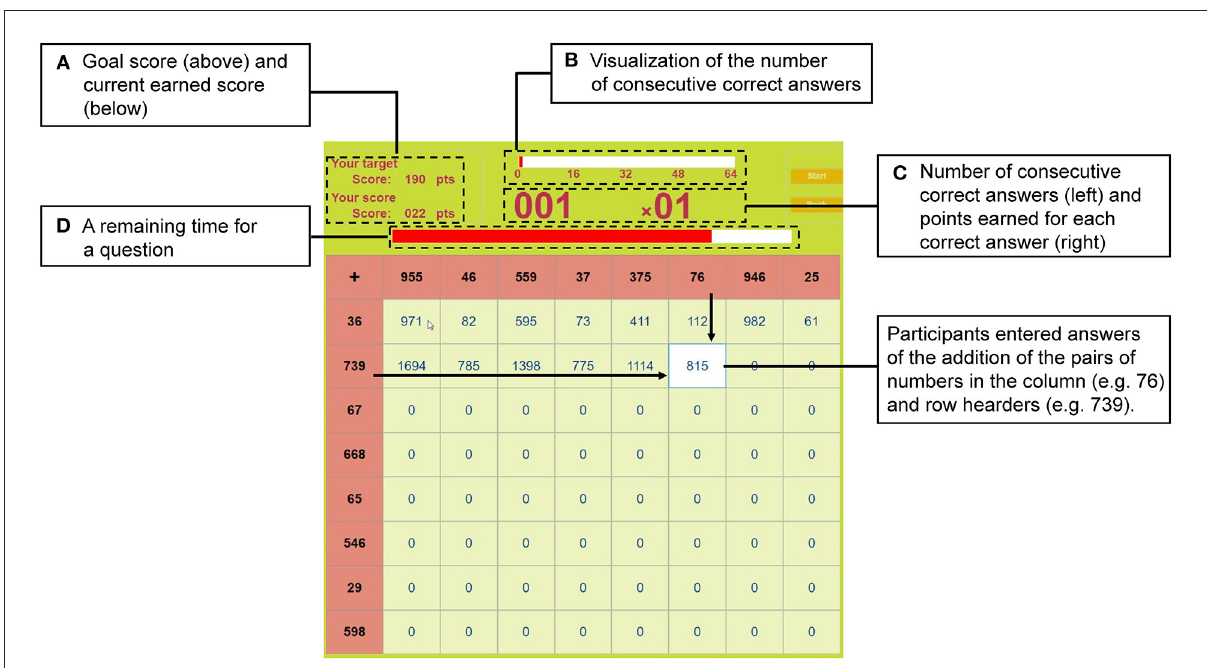
FIGURE1 The appearance of a gamified mental arithmetic graphical user interface application. The participant enters answers to addition sums using the number pairs in the column and row headers in sequence. After entering the answer, auditory feedback on the correctness of the answer is immediately provided. The goal score and the current score earned are shown in the upper left area (A) . Participants were instructed to confirm the goal score before starting the task and to try to exceed the goal score as much as possible. The number of consecutive correct answers is visualized by a bar (B) . Below the bar, the current number of consecutive correct answers and the points earned for each correct answer are displayed (C) . The points earned vary depending on the number of consecutively correct answers. The remaining time for each question is displayed as a progress bar (D) . If an answer is not entered within the time limit, negative feedback is returned, and the participants are automatically moved to the next question. The dashed squares are shown for illustration purposes only.